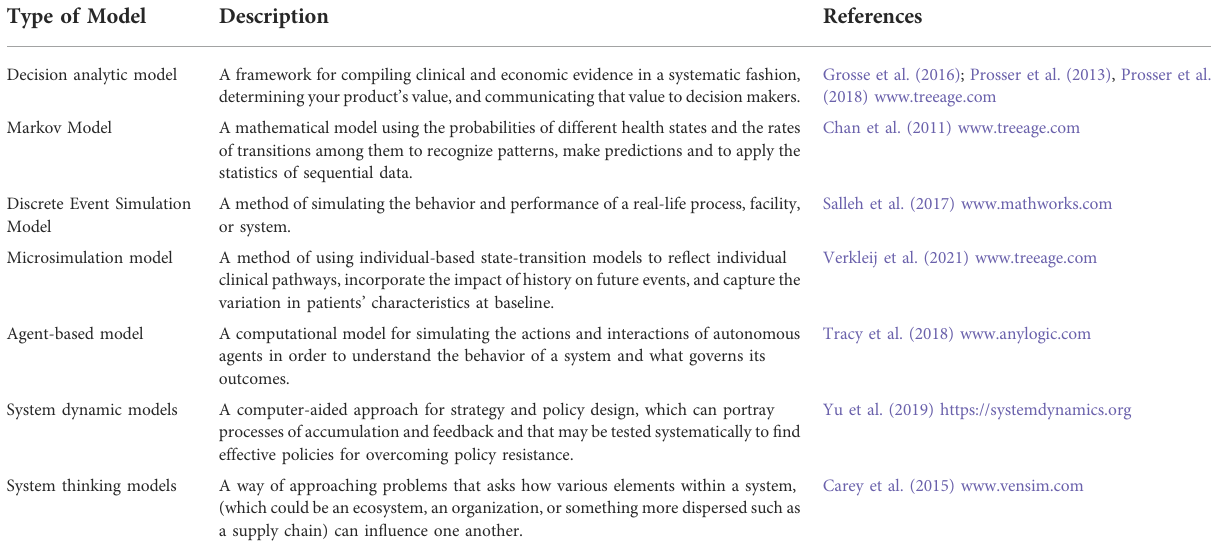
TABLE 3 Selected models proposed to address NBS